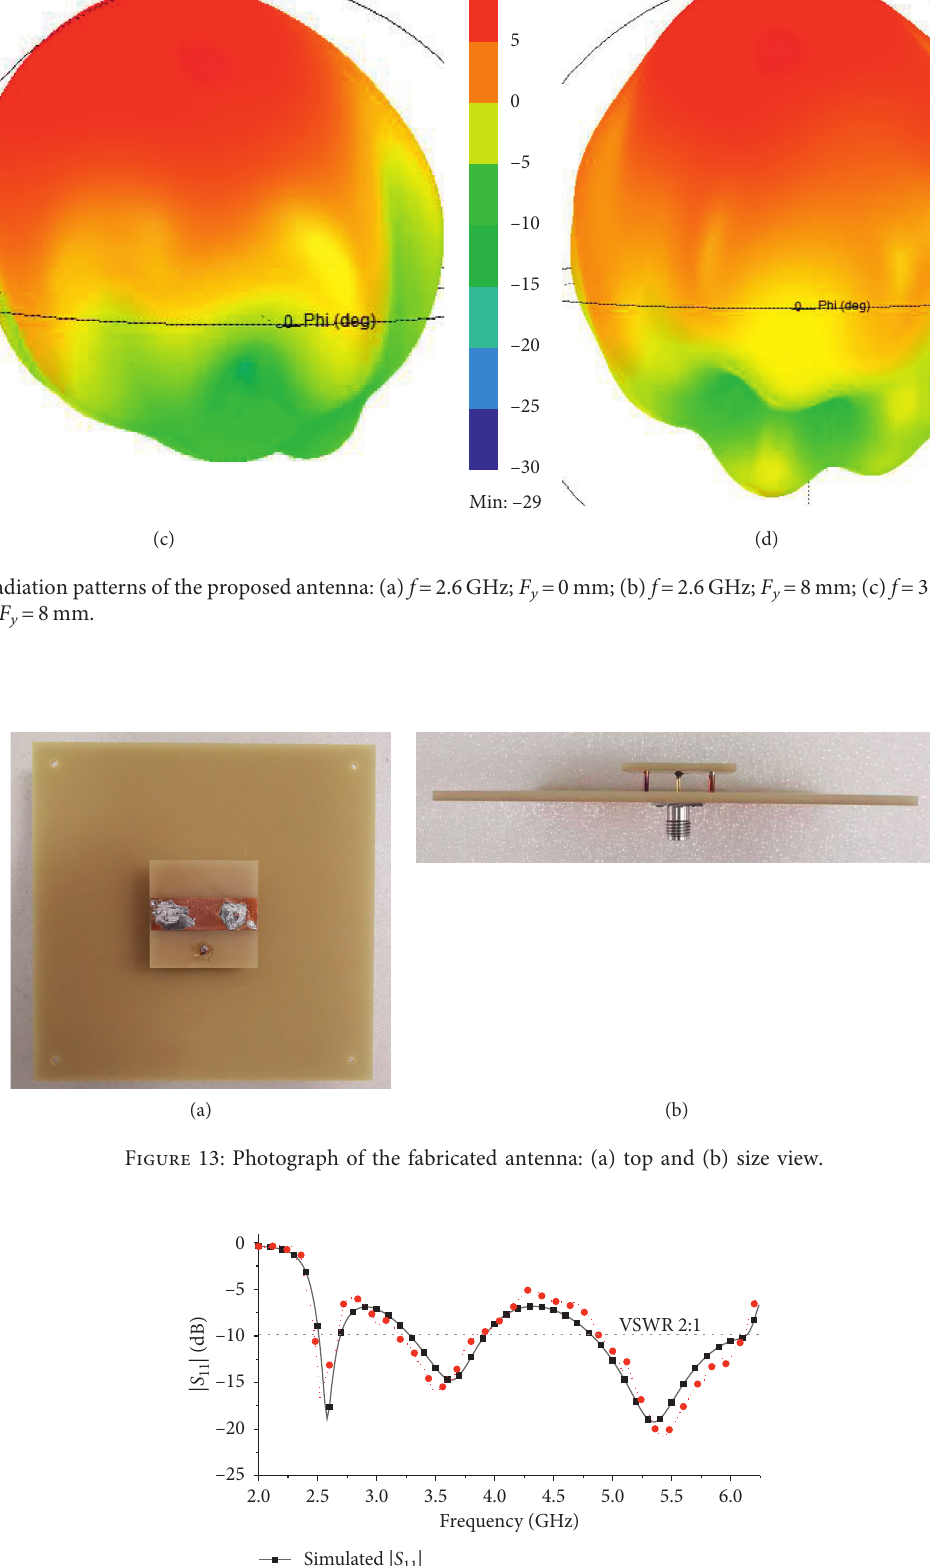
11 | of the proposed patch